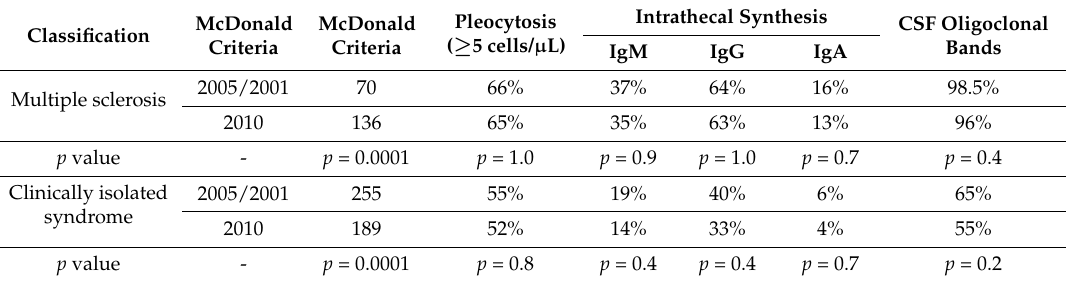
Table 3. The McDonald criteria